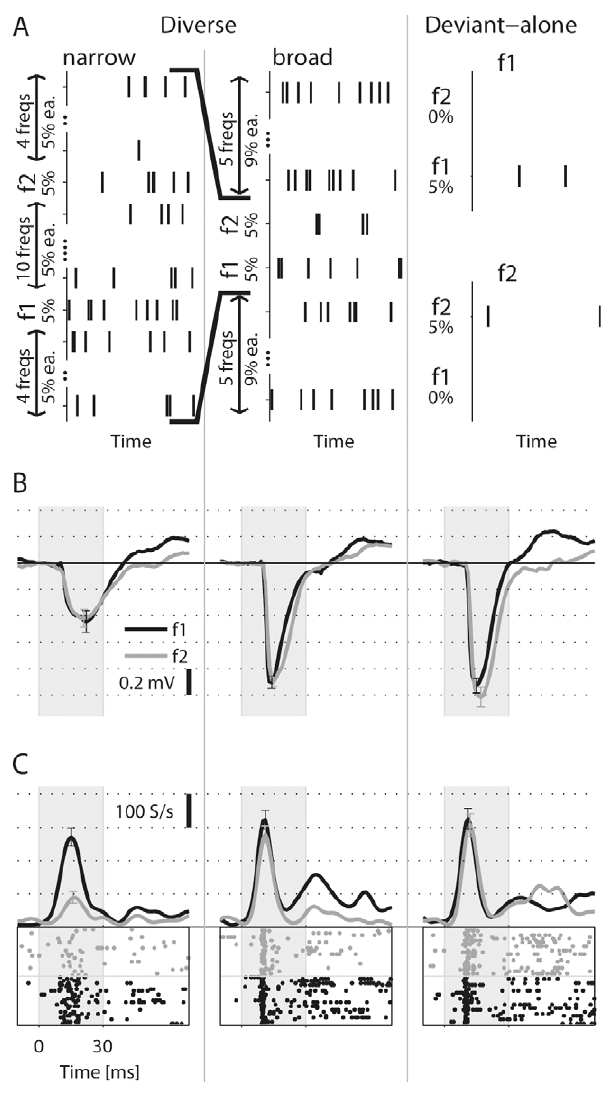
Figure 3. The control sequences. A. The three control conditions. In the ‘Diverse’ sequences, narrow and broad, the available frequencies were evenly spaced on a logarithmic frequency scale. The range of frequencies was narrow (about twice D f) in the Diverse-narrow sequence, and wide (11 D f) in the Diverse-broad sequence. In the ‘Deviant-alone f1’ and ‘Deviant-alone f2’ sequences, the other 95% of the presentations were silent. B. The average LFP responses to frequencies f1 and f2 embedded in the control sequences (same recording site as Fig. 1). The responses in the two Deviant-alone sequences are superimposed. Error bars: 6 s.e.m., shaded interval: stimulus. C. MUA Responses at the same site.